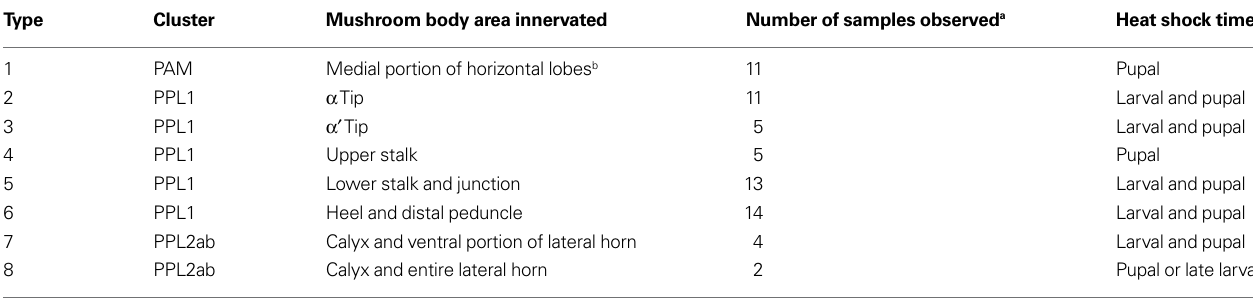
Table 2 | Classes of TH-GAL4 fl ip-out clones that project to the mushroom body.